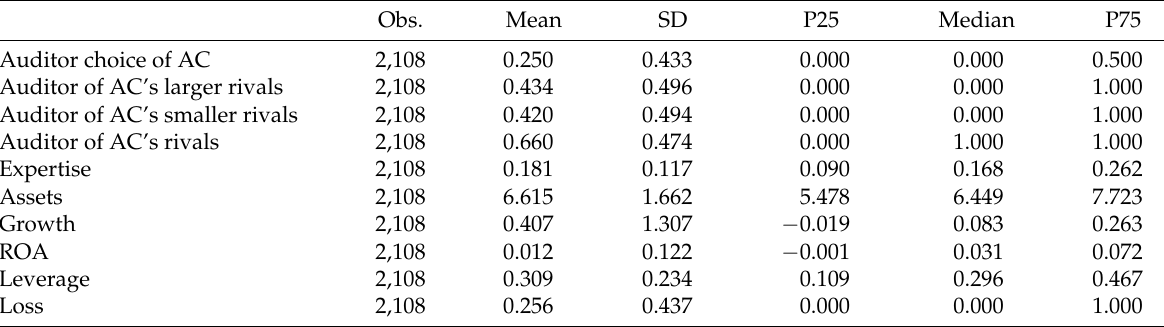
Table 2: Summary statistics and correlations: Main analysis Panel A. Summary statistics